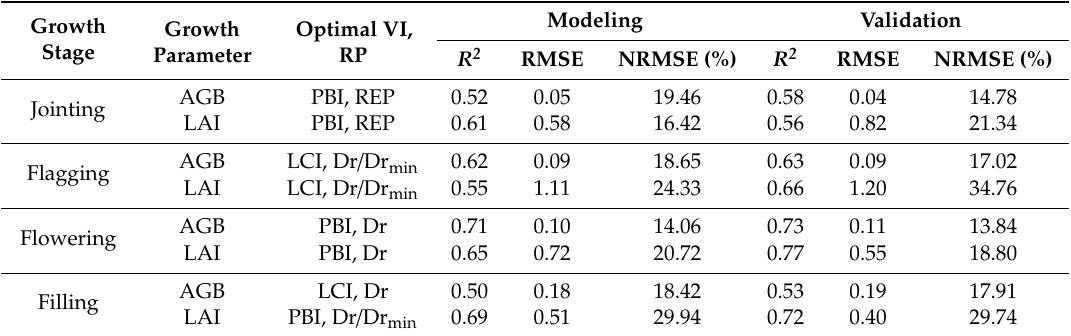
Table 6. Performance metrics for the estimates of winter-wheat growth parameters (AGB and LAI) obtained using a combination of the optimal vegetation index and the optimal red-edge parameter for di ff erent growth